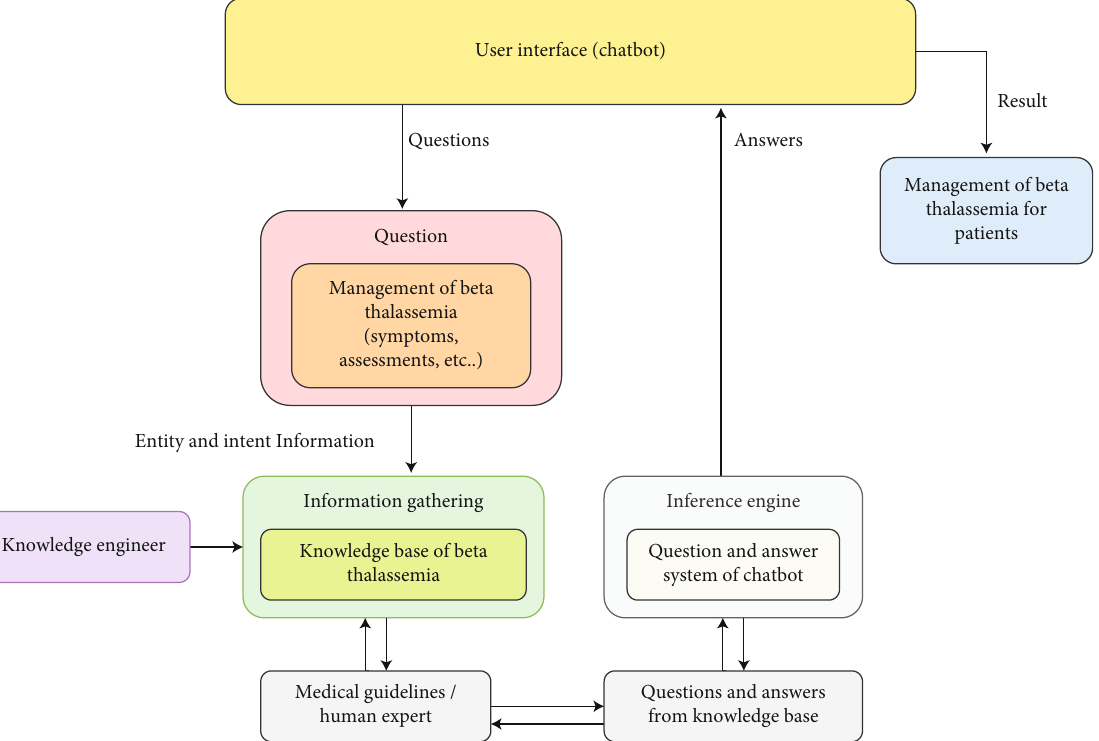
Figure 1: Framework of an expert system using the chatbot for the management of β -thalassemia